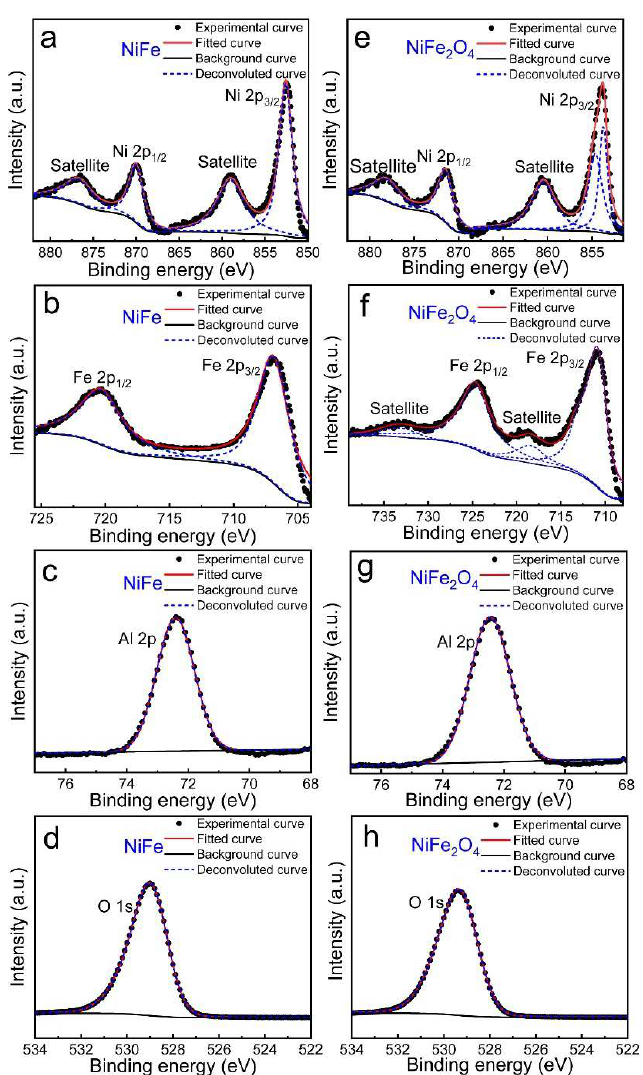
Figure 2. XPS spectra of ( a , e ) Ni 2p, ( b , f ) Fe 2p, ( c , g ) Al 2p, ( d , h ) O 1s of NiFe nanoparticles and NiFe/NiFe 2 O 4 core/shell nanoparticles, respectively.